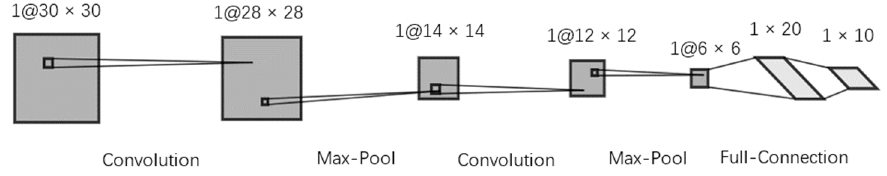
Figure 3. LeNet-3.3 network model. Figure 4. LeNet-2.22 network